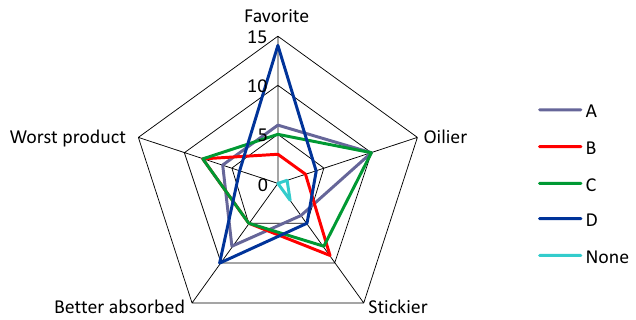
FIGURE 3 - Sensory characteristics of formulations according to 28 product testers. (A: vehicle; B: vehicle plus propolis extract; C: vehicle plus tocopheryl acetate; D: vehicle plus propolis extract and tocopheryl